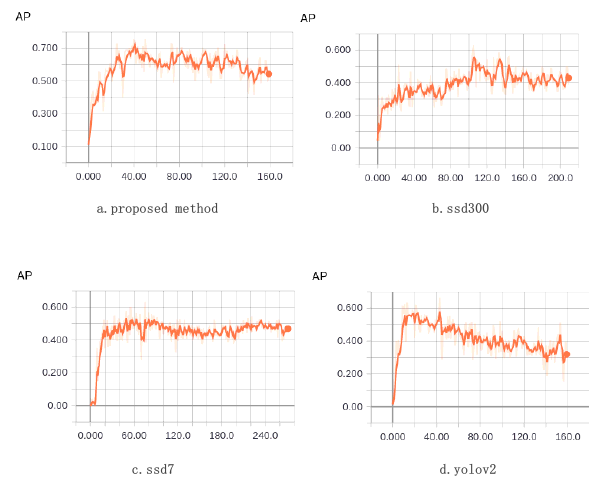
Figure 5. Comparison using our validation dataset for protrusion lesions detection during training: The a,b,c,d curves are for the average mean of our proposed method, SSD300, SSD7 and Yolov2 3/5000 respectively. From the curves, we can see our method performs a novel way to detect protrusion lesions.